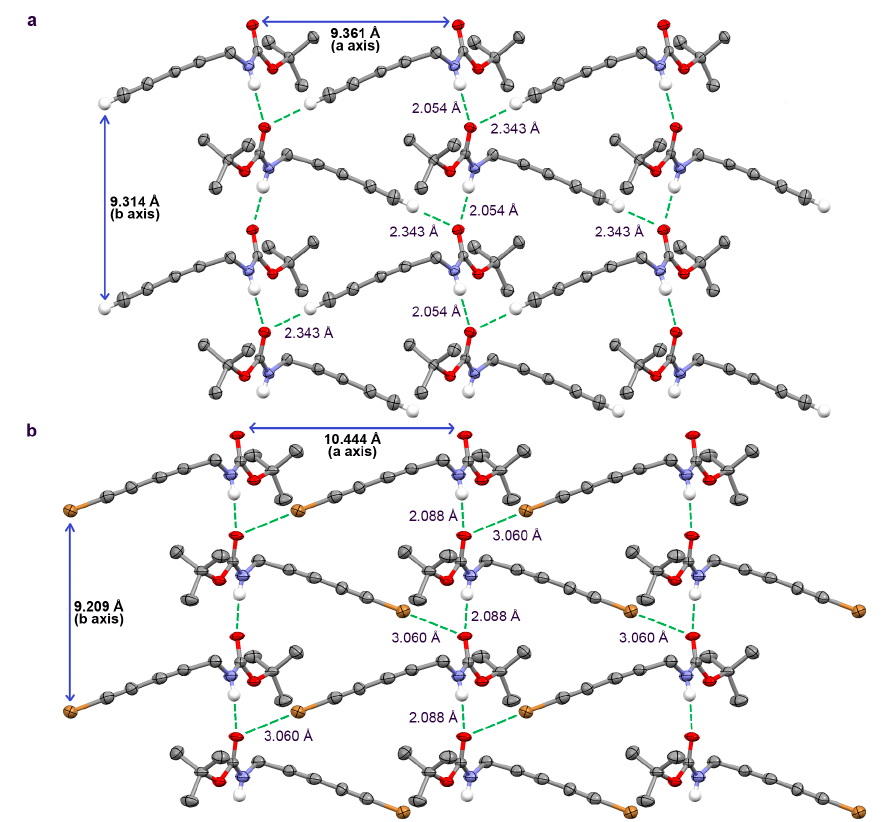
Figure 2. Halogen and/or hydrogen bonds inside the supramolecular walls of ( a ) diyne 1 and ( b ) bromodiyne 2 . The non polar hydrogen atoms have been removed for clarity.